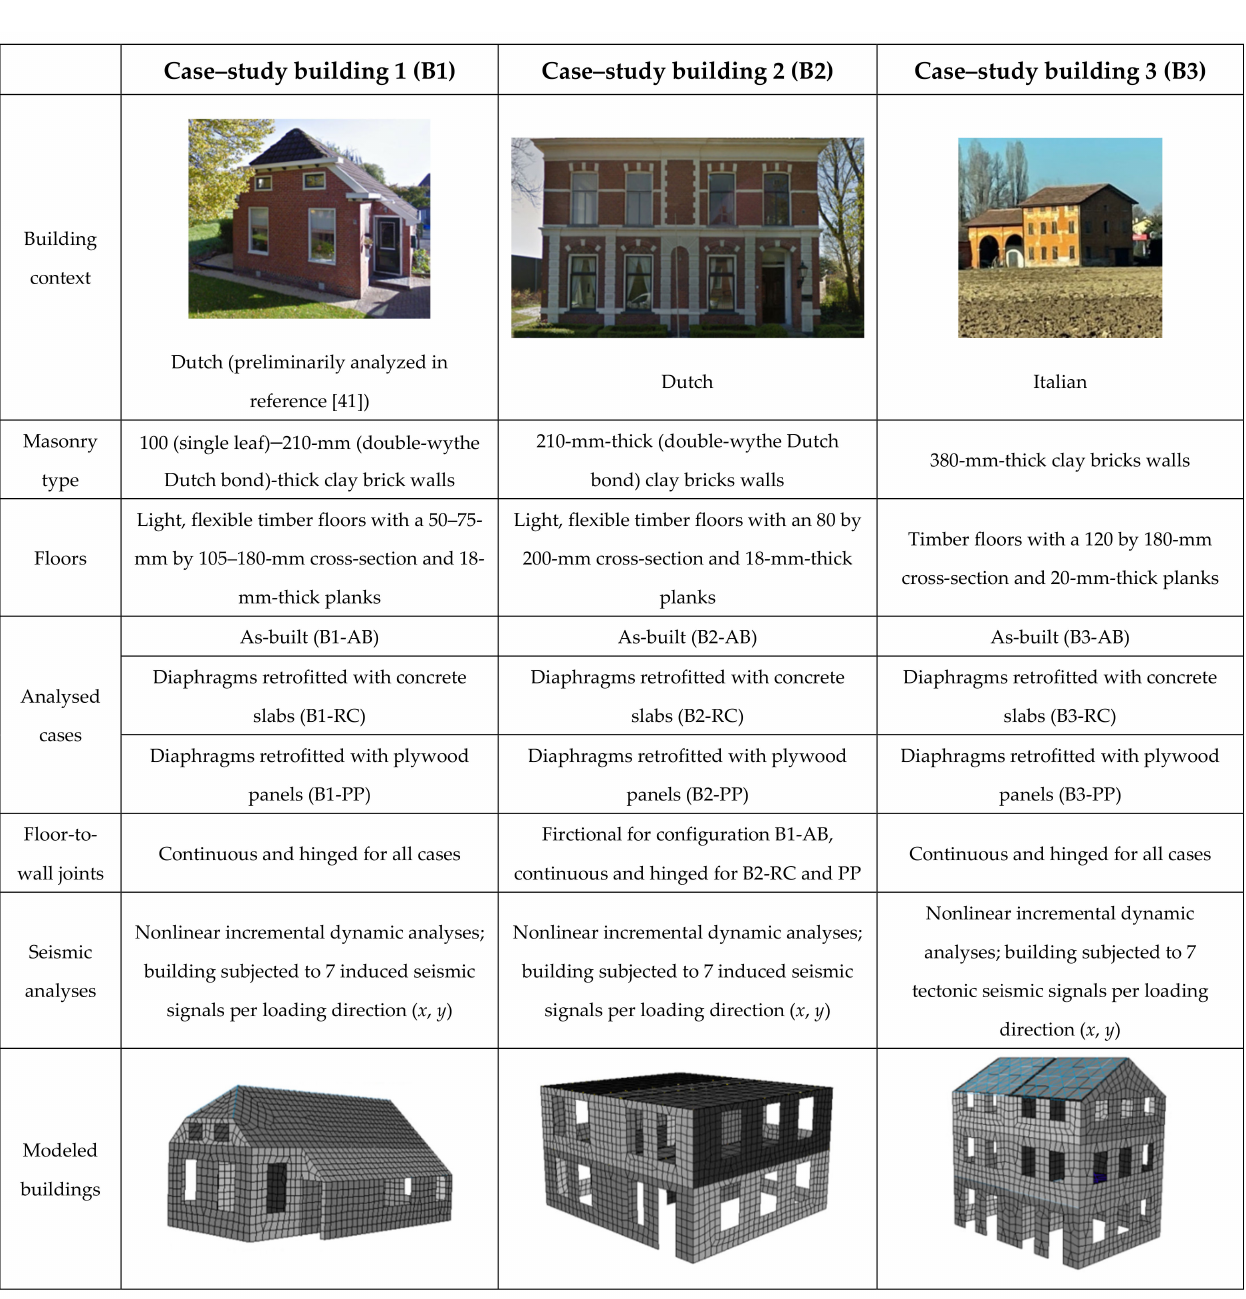
Figure 3. Overview of the three analyzed case–study URM buildings and their